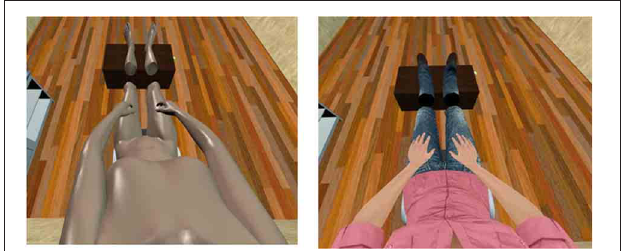
FIGURE 3 | Snapshots of the legs separation event are shown for the mannequin and human appearance modes in the case of a female participants. The legs separation event lasted 10s during which the legs moved away from the body reaching a maximum distance of 1m. The legs returned to their original position immediately after the 10s, recomposing a whole